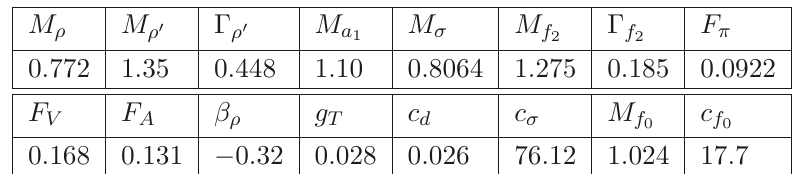
Figure 3 . Three pion q 2 spectrum d Γ π q 2 spectrum (right).